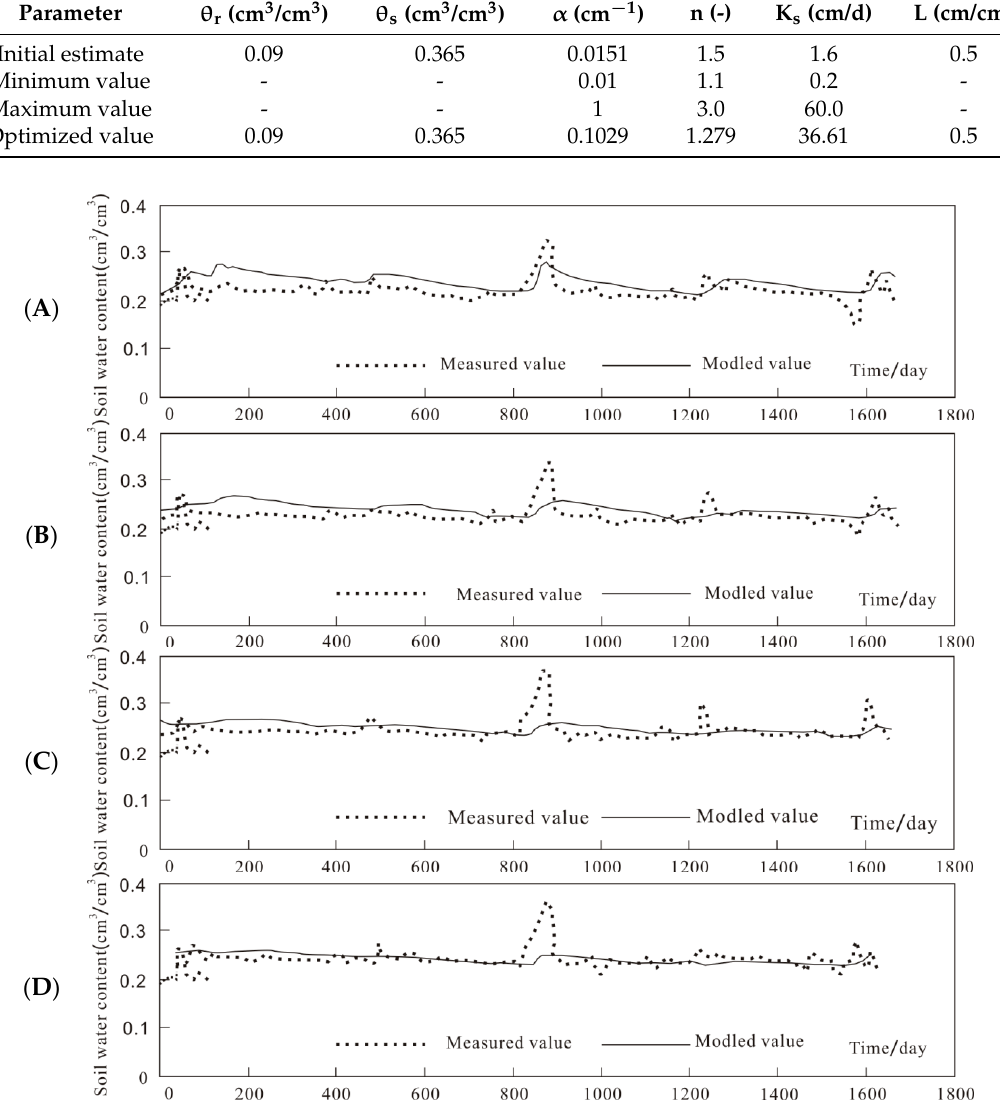
Figure 7. Comparison between measured and modeled soil water content values of different depths in the soil profile in the LC site at different depths of the soil profile: ( A ) 1.8 m; ( B ) 2.0 m; ( C ) 2.2 m; ( D ) 2.4 m.